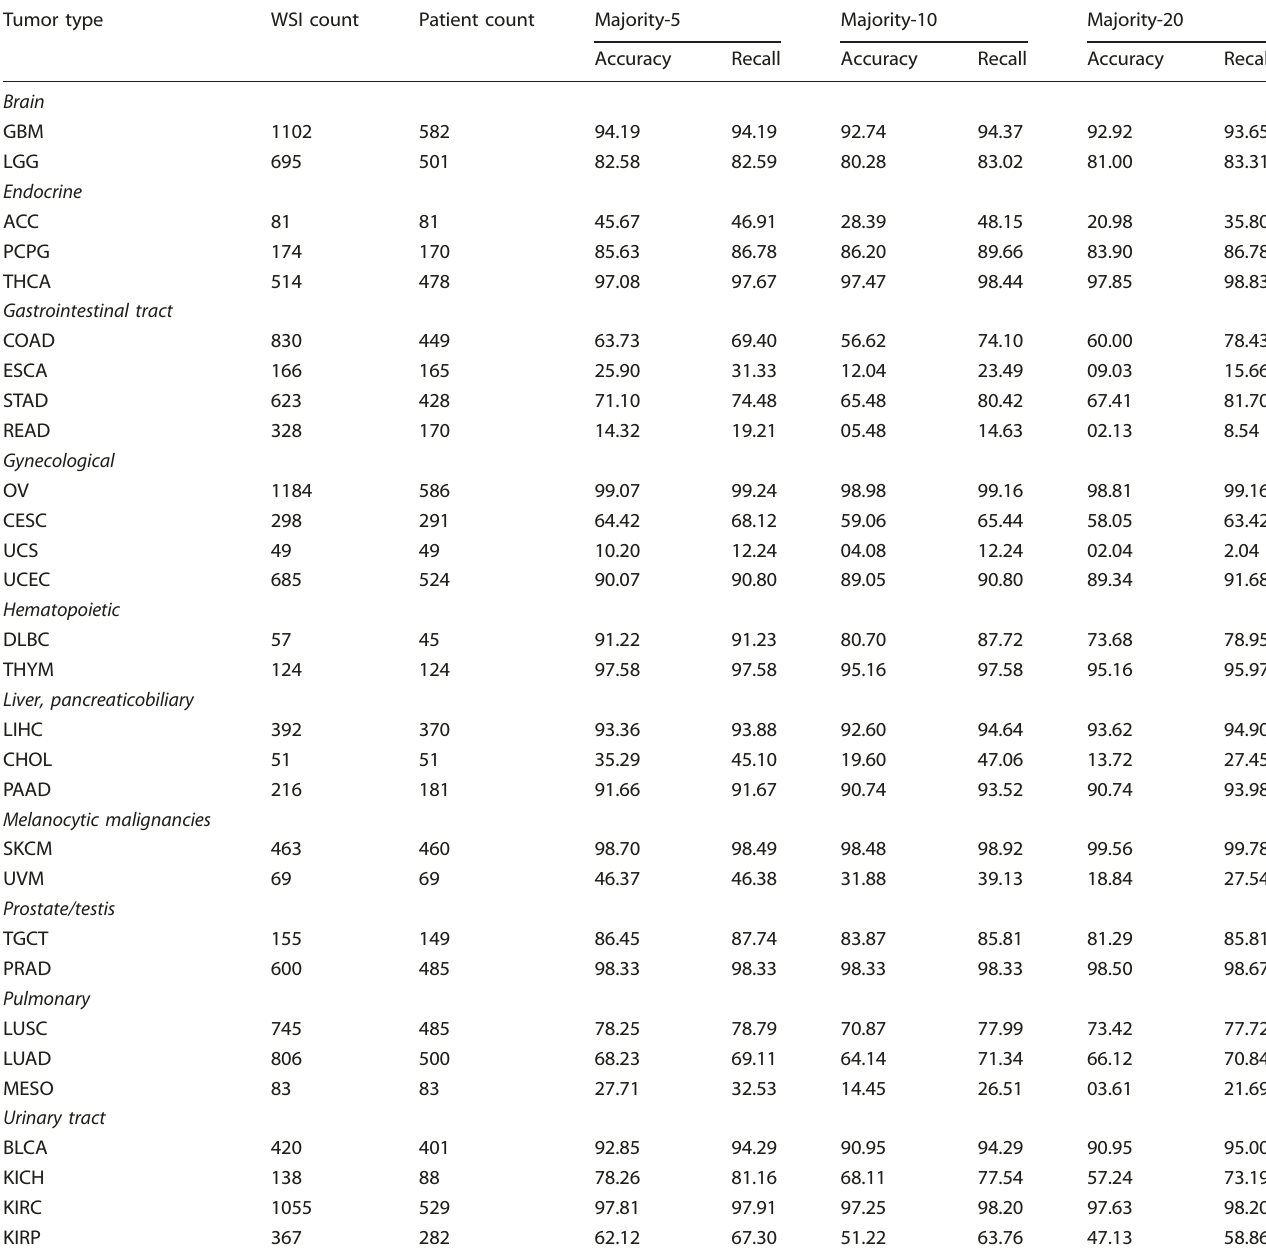
Table 3. Accuracy and recall (sensitivity) for cancer subtype identi fi cation (vertical search) among frozen section slides. Tumor